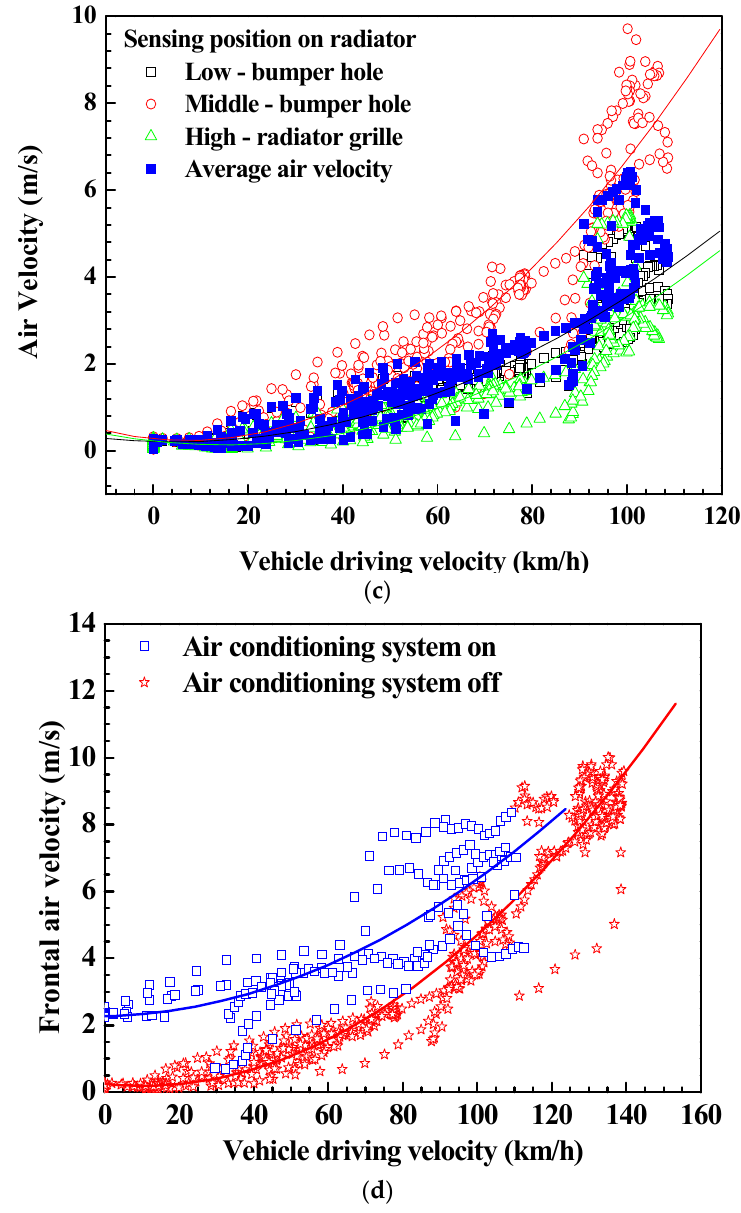
Figure 1. Schematic of the test set-up and frontal air velocity of the stack radiator. ( a ) Test set-up; ( b ) Photograph of the stack radiator; ( c ) Air velocity sensors of the stack radiator with measuring locations; ( d ) Averaged frontal air velocity of the stack radiator.